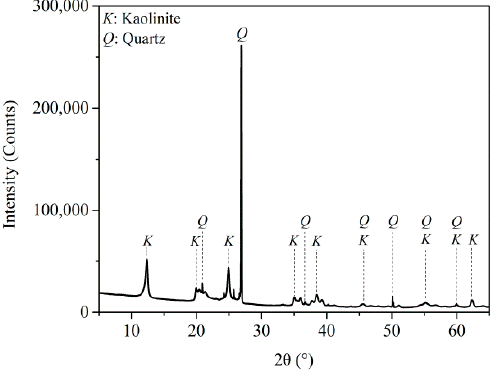
Figure 3. The XRD profile of GRS finer than 0.5 mm and identification of basic mineral compositions.